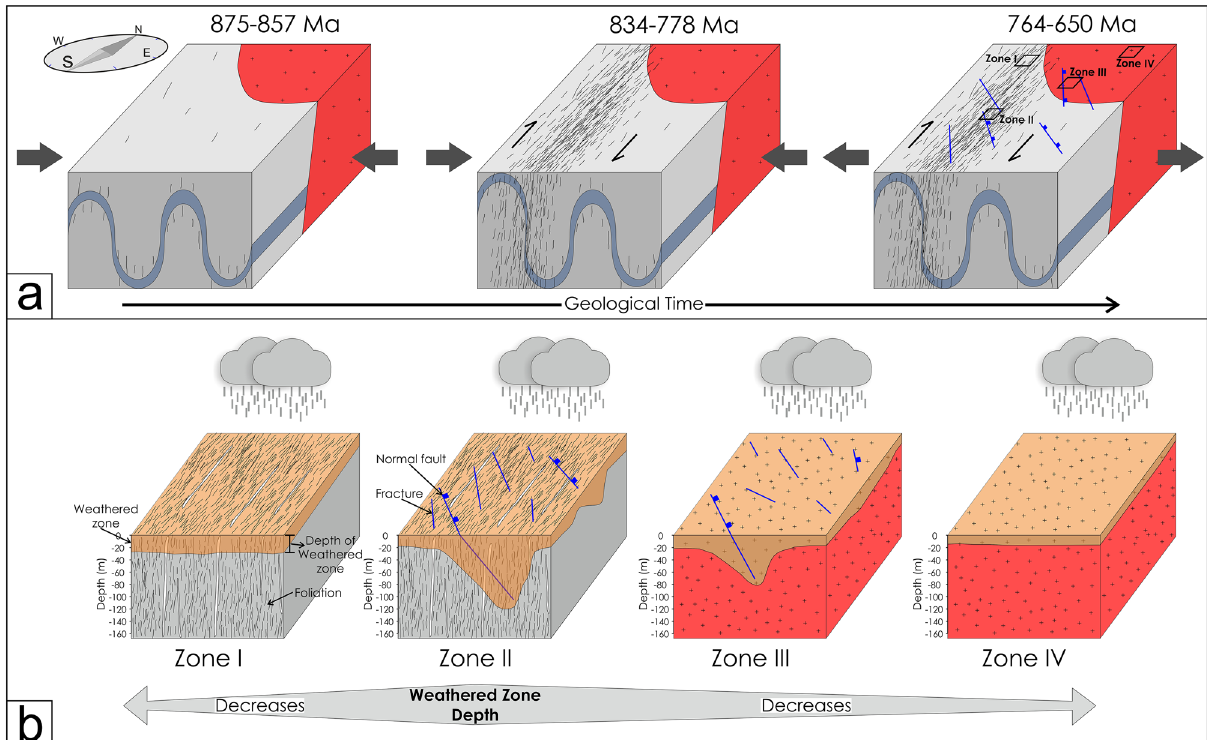
Figure 19. Conceptual model showing the different tectonic events and formation of respective weathered zone thickness. ( a ) Development of different planar fabrics over time. The early foliation was developed by the NE-SW compression between 875 and 857 Ma. The compression event is followed by an event of strike-slip shearing between 834 and 778 Ma. The last event, predominantly NE-SW extension, predominate the area between 764 and 650 Ma resulted the normal faults. Age data were compiled from Singh et al. 37 and Tiwari and Biswal 60 . ( b ) Structurally controlled bedrock weathering in different zones resulted variability in the weathered zone thickness. Zone-II and Zone-IV have a maximum and minimum weathered zone thickness area suggest the capability to store groundwater. The central part of the section is massive and is not suitable for groundwater storage due to the lack of void/fracture spaces. Profile-10 is collected along the SW-NE direction. The thickness of the top weathered zone is much less than other profiles collected in the study region. The identified fracture zone has been marked in the resistivity sec- tion. The profile shows the second layer (fractured zone) variation along the profile which is nearly 60 m thick at a profile distance starting from 450 to 600 m. This zone could be a potential site where recharge will be more. Like other profiles, massive granite is present in the basement (Fig. 15c). Profile-11 is oriented in the WNW-ESE direction. The weathered zone thickness is very less compared to other resistivity profiles in the study region. Small scale fractured zones were identified and marked in the resistivity section (Fig. 15d). Although the ERT profile is taken on a brittle zone, no such deep fractured zone has been identified. The resistivity model shows two distinct resistivity zones. The top 10-20 m show very low resistivity values ranging from 10 to 100 Ω-m followed by massive granite/granulite of 500–3000 Ω-m. Zone-IV: Localities devoid of foliation, fracture, and faults (undeformed zones). Three ERT traverses (P12:Kansara, P13:Surela, P14:Padni) have been performed over massive granite or mafic granulite to under- stand the resistive nature of the subsurface (Figs. 1, 16a–c). The observed resistivity model shows low resistivity zones extending up to 15 m. These zones vary across the traverse of each section which shows the weathered profile variability (5–15 m). The resistivity value ranges from 10 to ~ 10 5 Ω-m with two discrete features such as top weathered zones and highly resistant massive granite/mafic granulite below the weathered zone (Fig. 16a–c). Precipitation, groundwater table, and aquifer parameters. In this study, three rainfall stations were taken into consideration to understand the precipitation pattern in the last two decades. It shows that in a particular year, the precipitation almost remains the same throughout the region (Fig. 17). The groundwater table depth varies from a meter to several meters in the study region. The water table data displays that the area bounded between the Surpagla-Kengora- and Kui-Chitraseni-fault is relatively low water table depth (see Appendix 2,3) both in pre-monsoon and post-monsoon periods. Further, the aquifer parameter, transmissivity (T) of eight boreholes (estimated from Theis recovery 59 ) were used for a correlation with different structural zones (Zone-II and Zone-III) (Table 2). The result shows that Zone-II (1.46–2.84 m 2 /day) has relatively higher